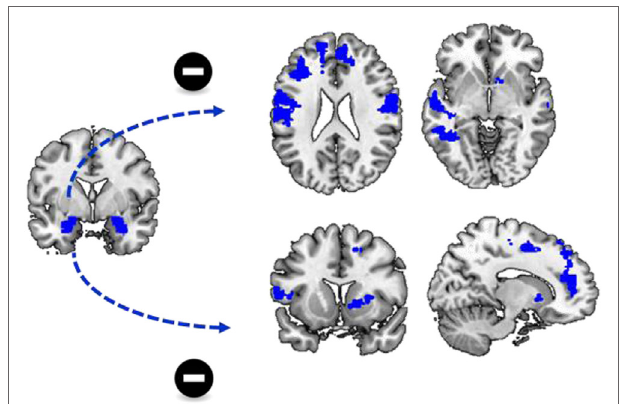
FigUre 4 | State anxiety and functional connectivity. There was a significant negative correlation between state anxiety and functional connectivity between the left amygdala and a variety of brain regions including the dorsal and ventral medial prefrontal